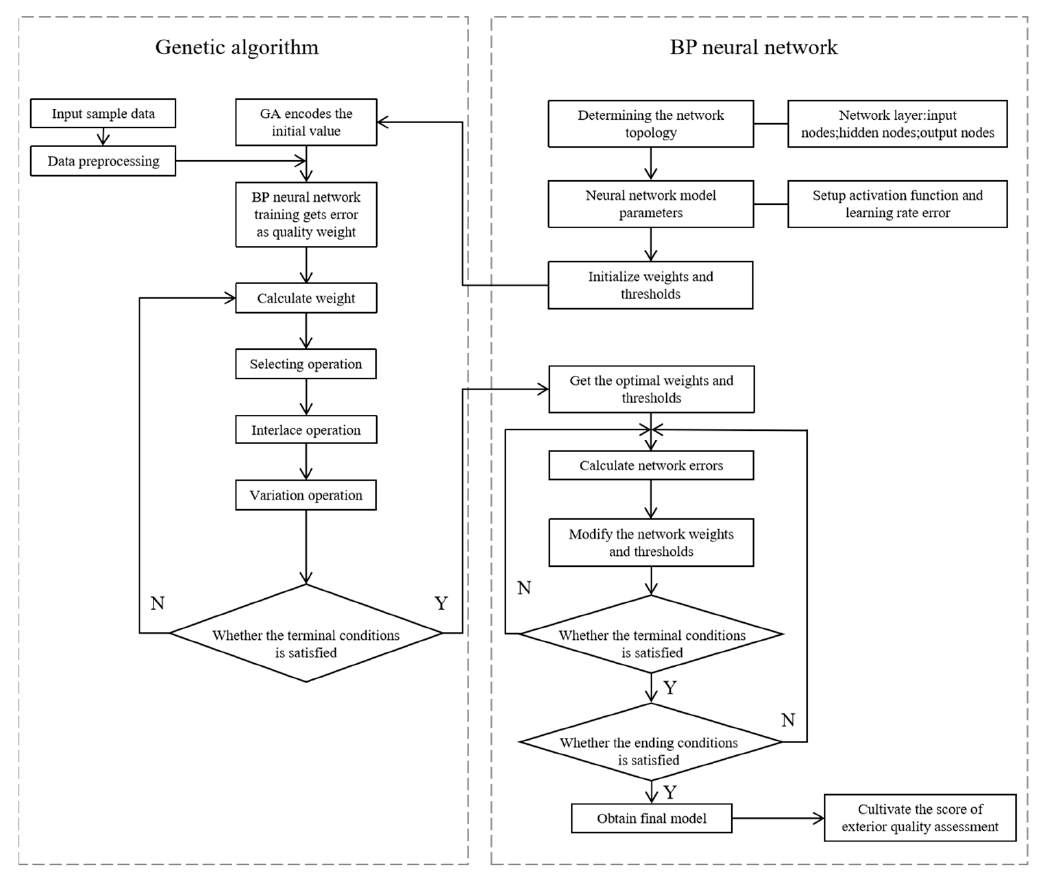
Figure 3. The flow of the GA–BP neural network model.